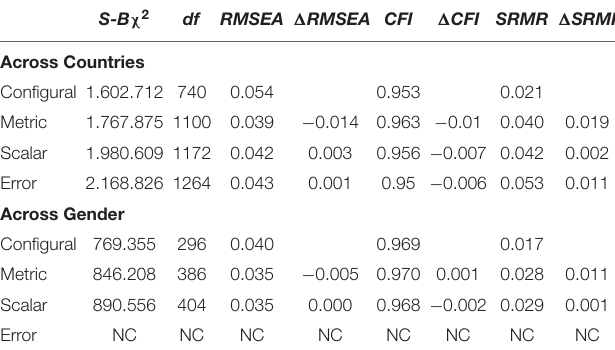
TABLE 4 | Goodness-of-fit indices of measurement invariance of the PBA bifactor ESEM model across countries and gender.